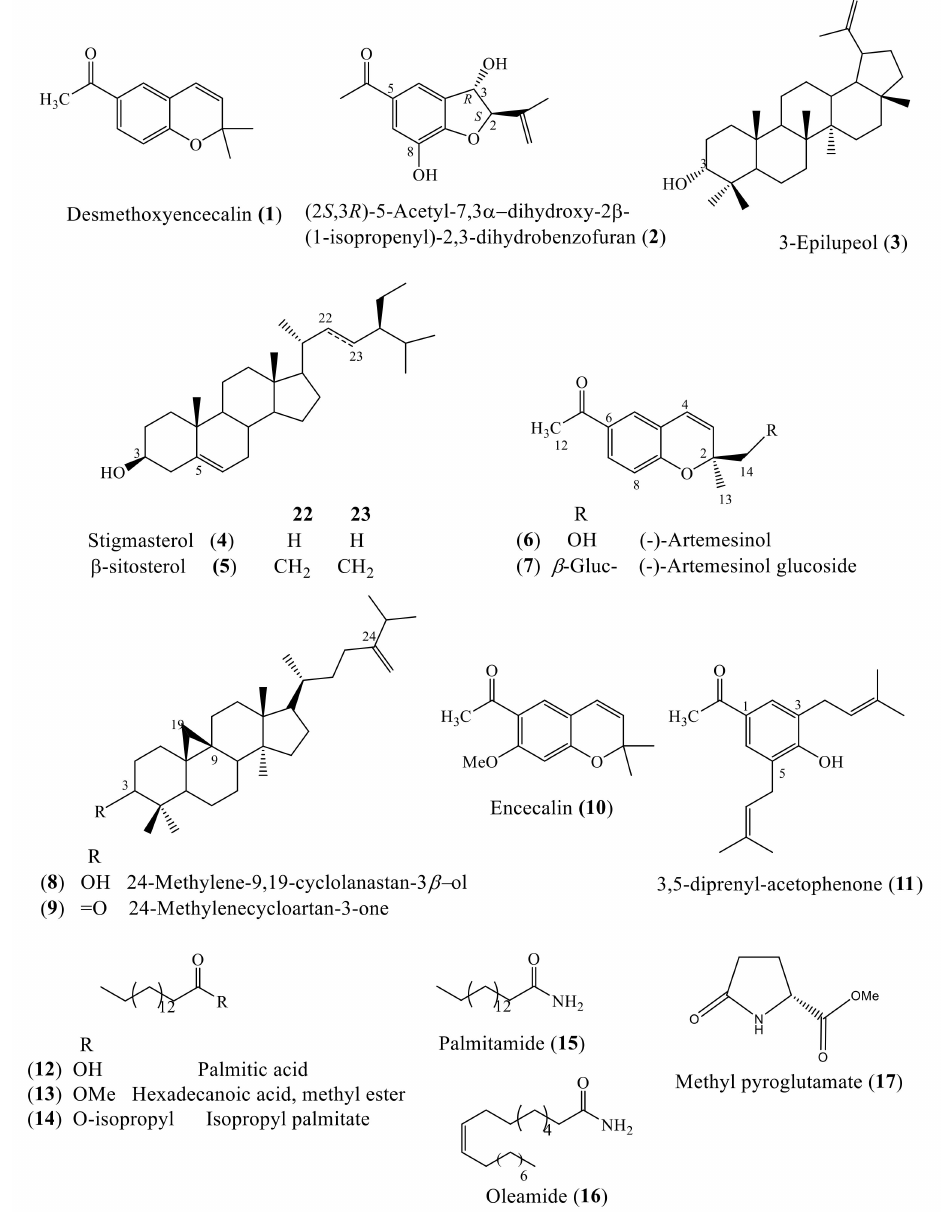
Figure 4. Chemical structures of compounds identified in the cell suspension culture of A.